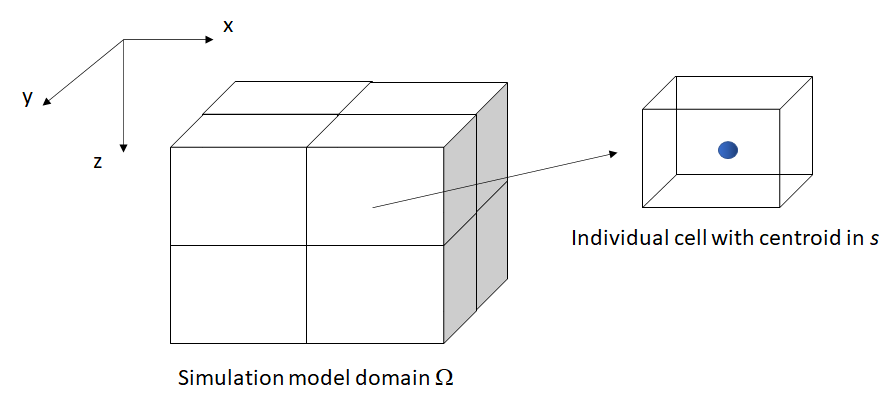
Figure 5. Dividing the reservoir model into discrete cells; the principles of numerical